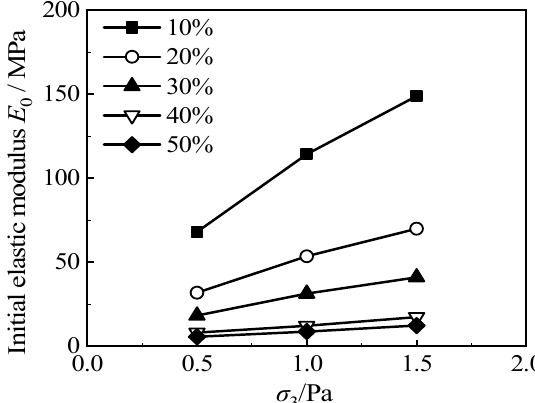
Figure 9. The E 0 ~ σ 3 /Pa curve of RCS soil when the cement content is 3.5 g/100 mL. Figure 10 is the relationship between the E 0 ~ σ 3 /Pa of RCS soil with 20% rubber